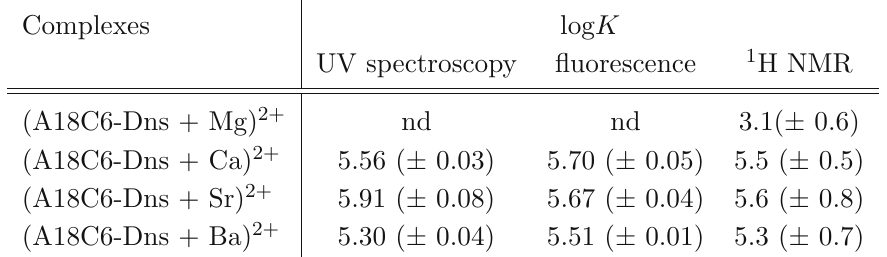
Table 1 The stability constants of complexes of A18C6-Dans with Mg 2+ , Ca 2+ , Sr 2+ and Ba 2+ in acetonitrile solution determined by the UV spectroscopy, spectrofluorimetry and 1 H